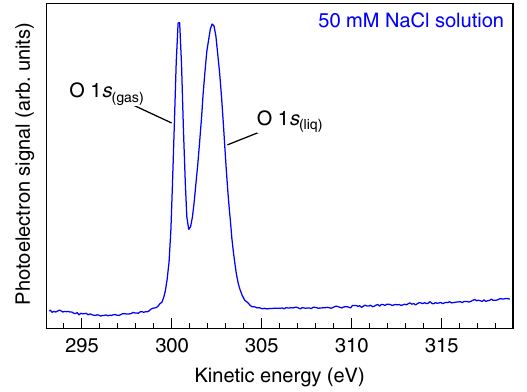
FIG. 8. Reference O 1 s spectrum in the absence of nano- particles. Spectrum of 50-mM NaCl solution (no silica NPs) under identical conditions to those presented in Fig. 2(b). The region between 310 and 314 eV is flat in the absence of the